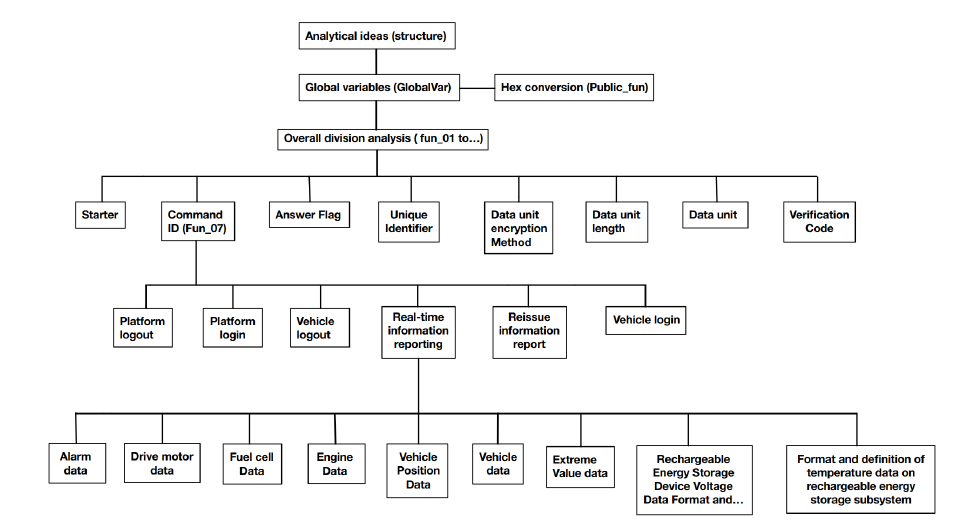
Figure 7. Analysis of code